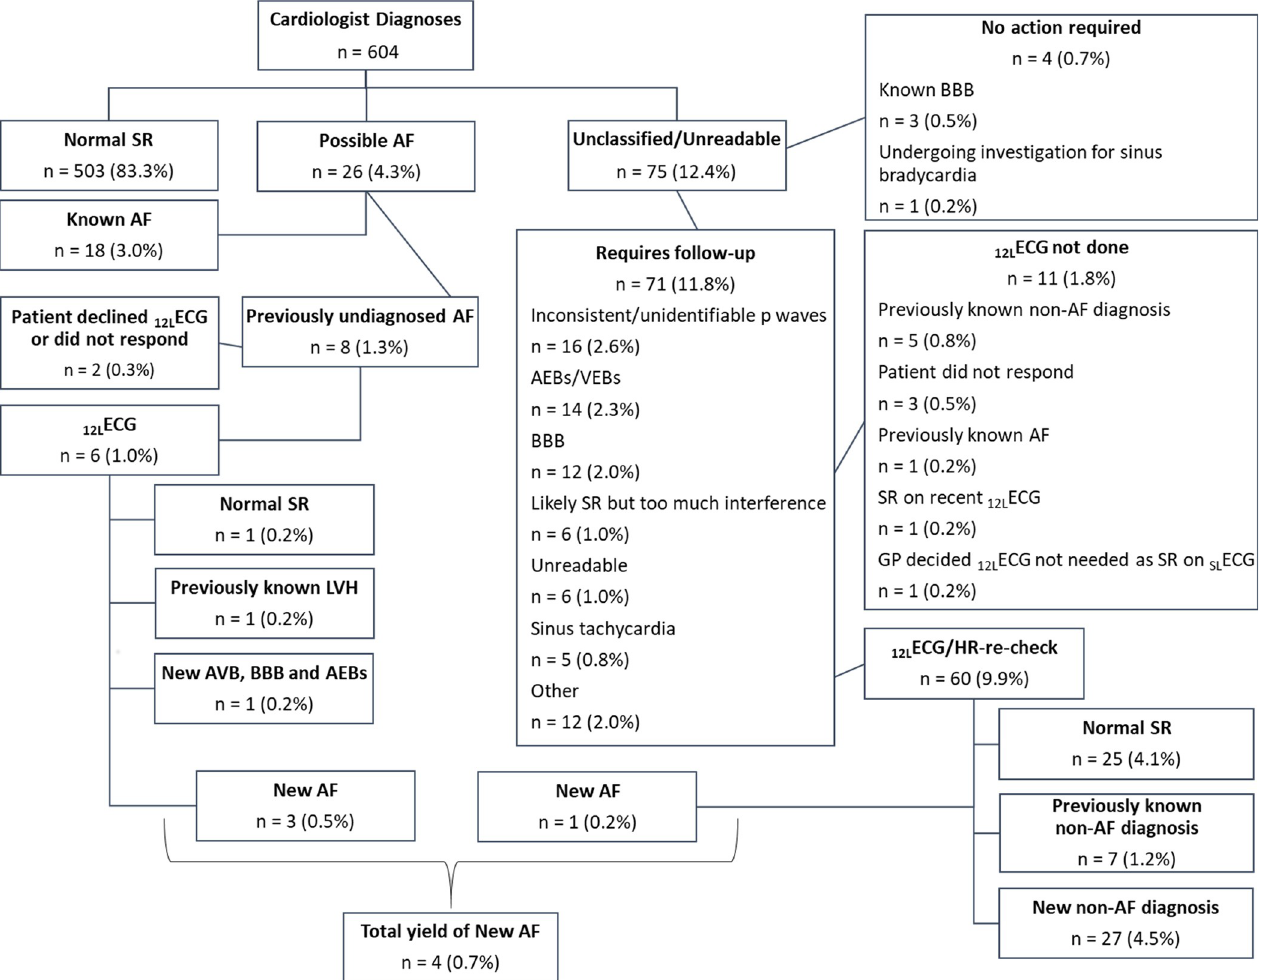
Fig 3. Flowchart of follow-up actions and outcomes. 12L ECG, 12-lead ECG; AEB, atrial ectopic beats; AF, atrial fibrillation; AVB, first-degree atrioventricular block; BBB, bundle branch block; GP, general practitioner; HR, heart rate; LVH, left ventricular hypertrophy; SL ECG, single-lead electrocardiogram; SR, sinus rhythm; VEB, ventricular ectopic